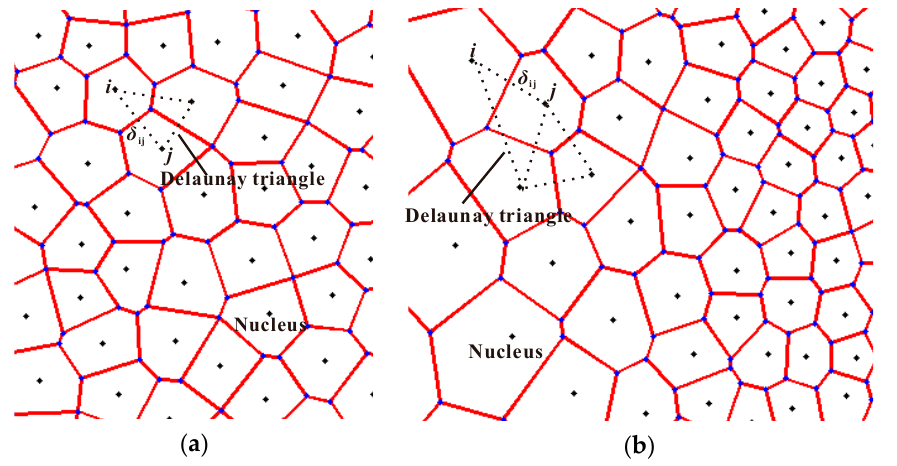
Figure 9. 2D random Voronoi technique: ( a ) uniform honeycomb (k = 0.2); and ( b ) graded honeycomb (k = 0.2).